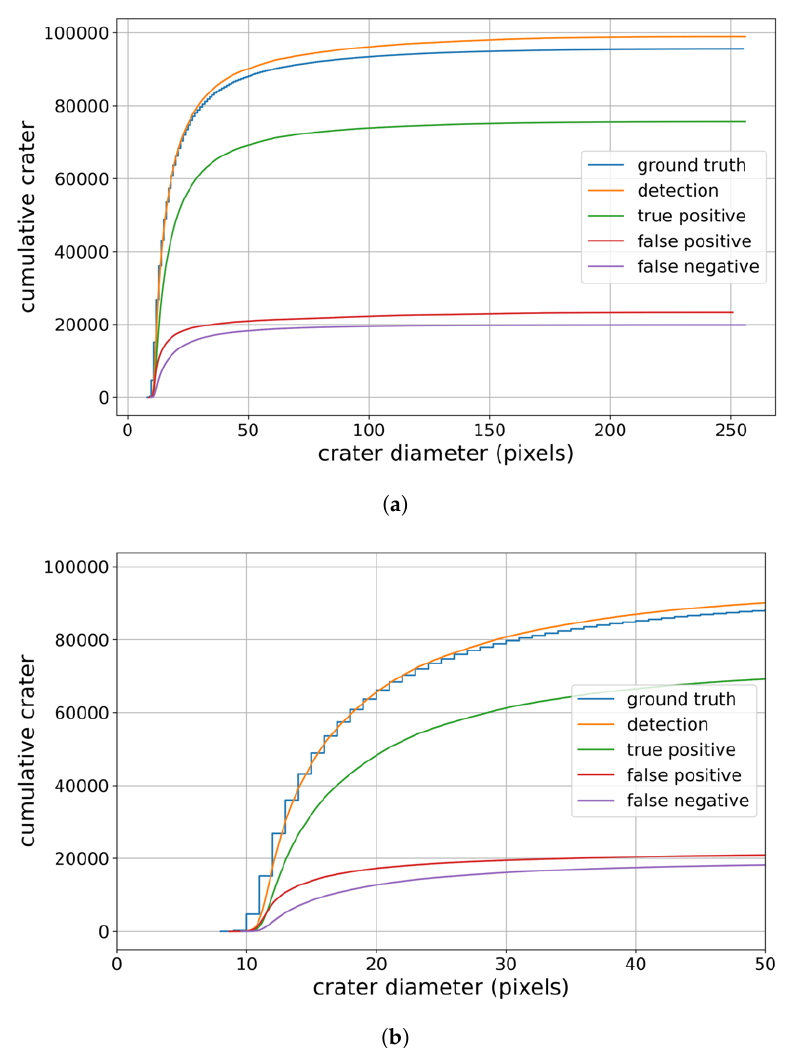
Figure 6. A detailed analysis of detection results: ( a ) Cumulative plot for ground-truth and model prediction results of craters of all sizes; ( b ) A closer look at the cumulative plot in ( a ) for ground-truth and model prediction results of craters with diameters less than 50 pixels (5